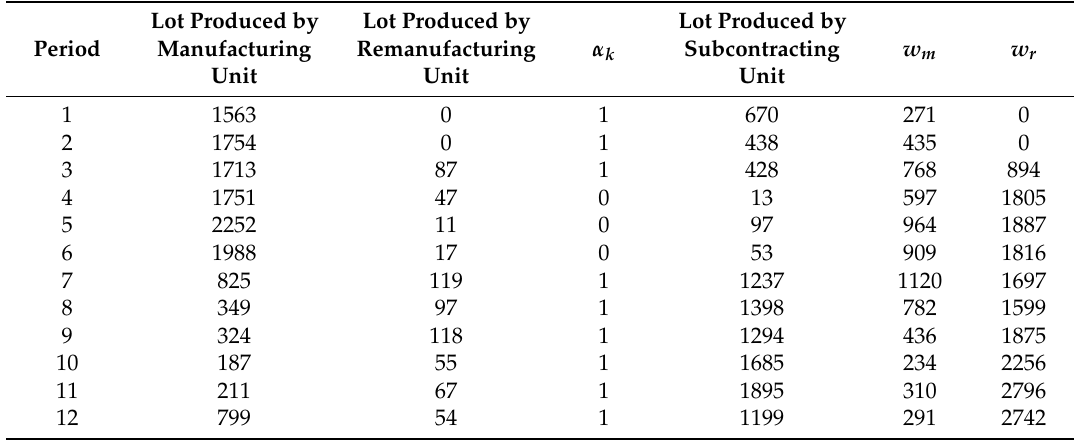
Table 3. Production plan with C ps = 35; C c = 3550.